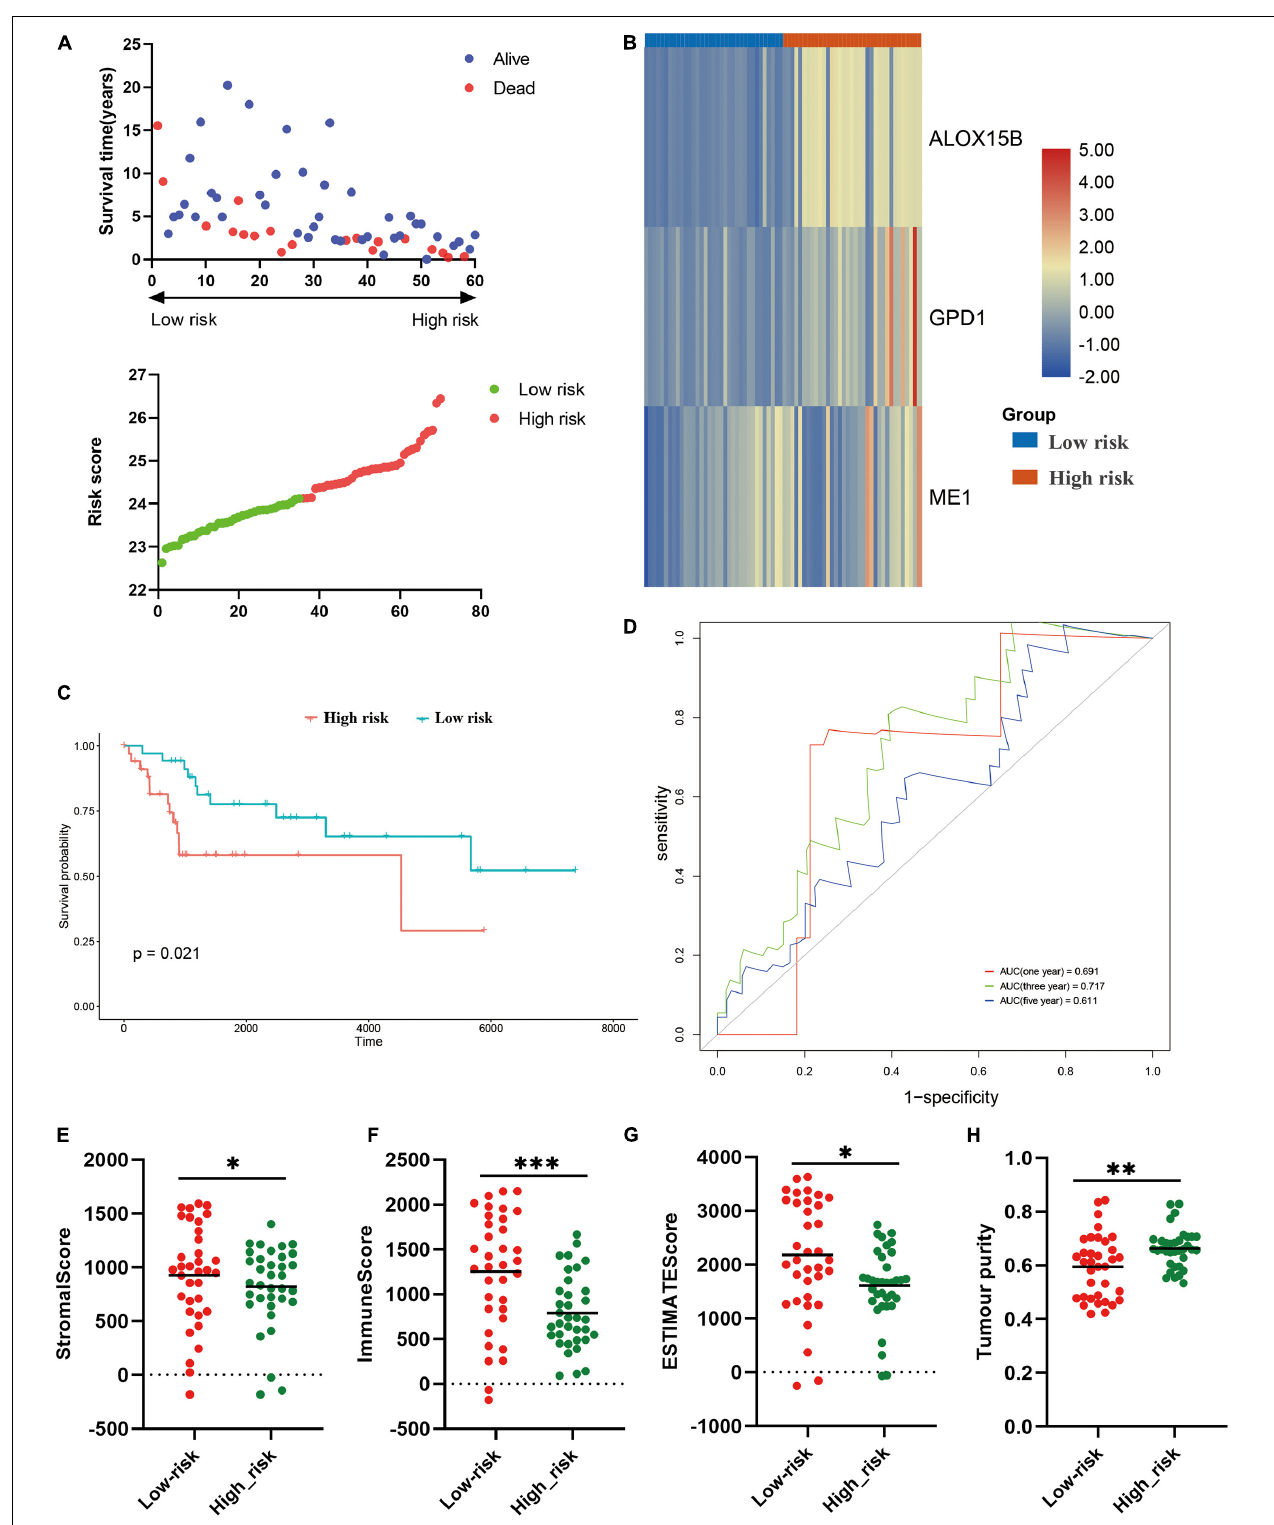
FIGURE 7 | Validation of the constructed risk model in the verification cohort. (A) distribution of survival status and risk score, (B) heatmap illustrating the expression of three candidate genes in the verification cohort, (C) survival curve of the patients in the high and low risk groups in the verification cohort, (D) ROC curve of the risk model in the verification cohort, (E–H) stromal score, immune score, ESTIMATE score and tumor purity calculated by ESTIMATE algorithm. * p < 0.05; ** p < 0.01; *** p < 0.001.